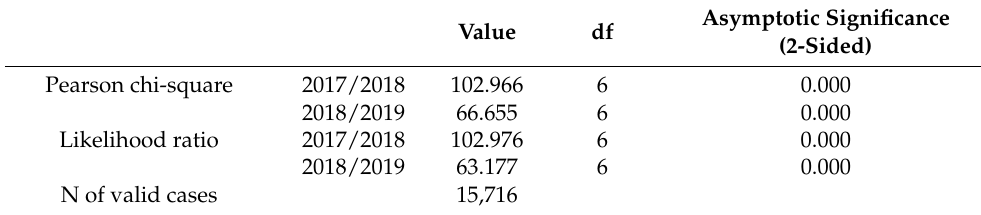
Table 4. Chi-square test (legal form vs. discretionary accruals).